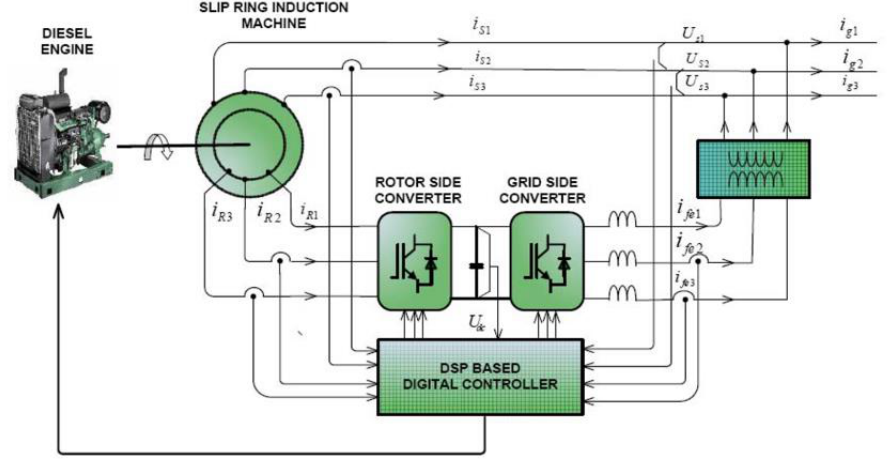
Figure 8. The basic configuration of DFIG coupled by diesel engine [57].